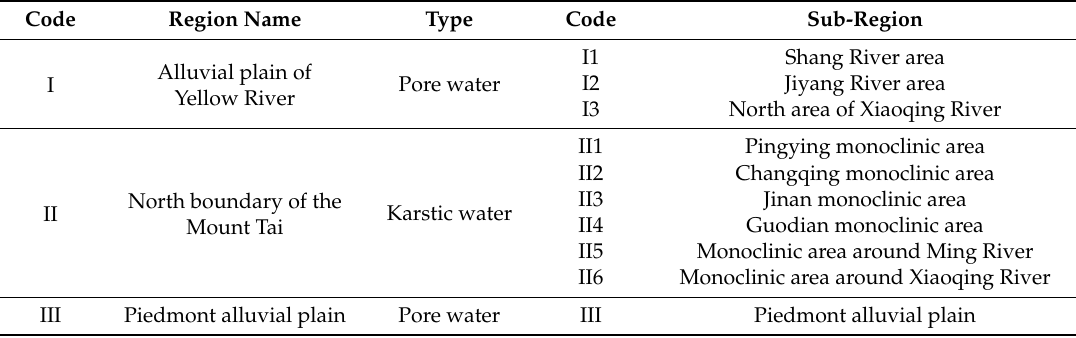
Table 1. Table of hydrogeological partition of Jinan karstic spring